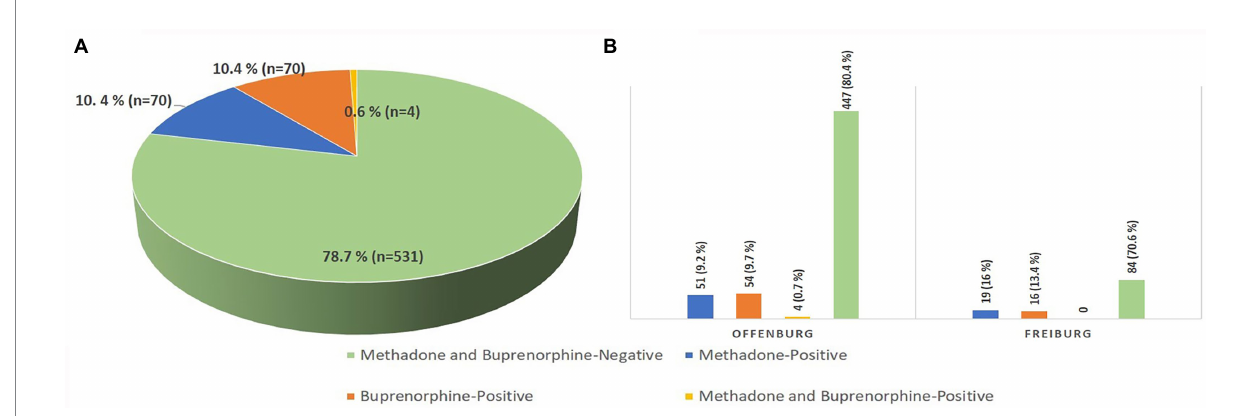
FIGURE 1 Results of the qualitative analysis of urine samples from the prison population investigated in total (A) and, separated by prison (B) . (A) Out of 675 tested samples, 70 samples (10.4%) tested positive for methadone, 70 samples (10.4%) tested positive for buprenorphine, 4 samples tested positive for both substances, and 531 samples (78.7%) tested negative for methadone and buprenorphine. (B) Out of the 556 samples tested in the Offenburg prison, 51 samples (9.2%) tested positive for methadone, 54 samples (9.7%) tested positive for buprenorphine, 4 samples (0.7%) tested positive for both substances and 447 samples (80.4%) tested negative for methadone and buprenorphine. Out of the 119 samples tested in the Freiburg prison, 19 samples (16%) tested positive for methadone, 16 samples (13.4%) tested positive for buprenorphine and 84 samples (70.6%) tested negative for methadone and buprenorphine.